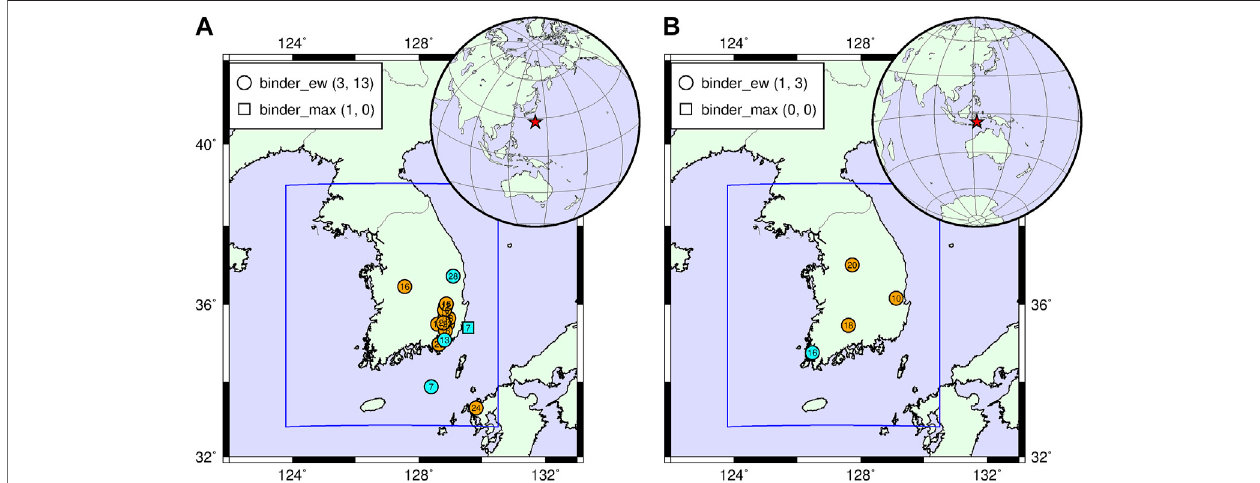
FIGURE 3 | Epicenters of associated events for regional and teleseismic earthquakes including association results for (A) the April 18, 2020 Bonin Island Mw 6.6 Earthquake at a depth of 453 km and (B) the August 21, 2020 Banda Sea Mw 6.9 Earthquake at a depth of 627 km. Red stars represent the epicenters located by the U.S. Geological Survey ’ s National Earthquake Information Center (NEIC), while circles and squares represent the epicenters of events associated by binder_ew , and binder_max ,respectively.Numbersinsymbolsrepresentthenumberofphasesfortheassociation,whilenumbersinparenthesesdenotethenumberofassociated events (cyan) and removed events (orange), respectively.